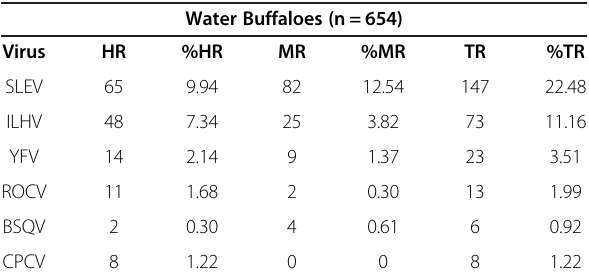
Table 1 Prevalence of hemagglutination-inhibition antibodies against antigens of six flaviviruses in serum samples of water buffaloes from different regions of Pará state, Brazilian